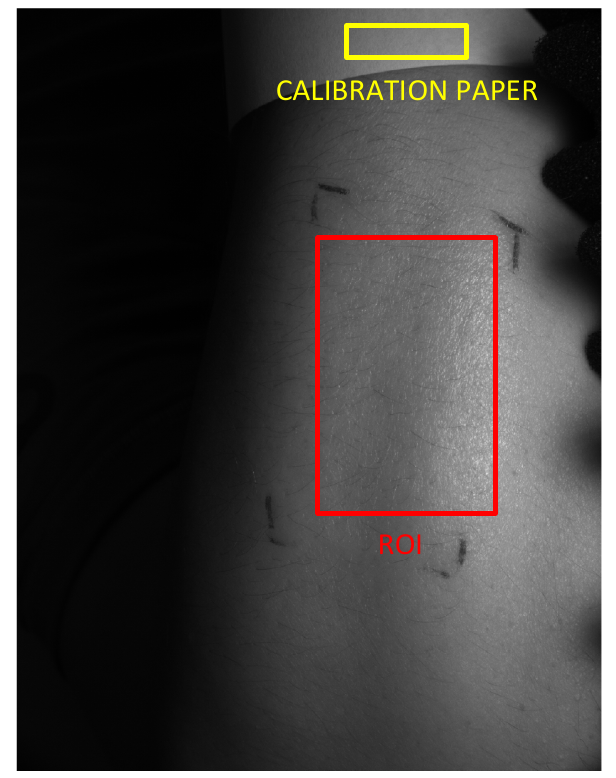
Figure 12. Region of interest and white paper for software calibration.